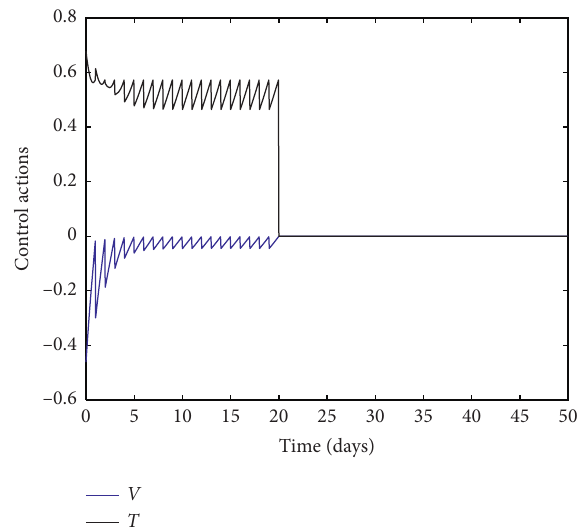
Figure 2: Vaccination and treatment actions calculated from